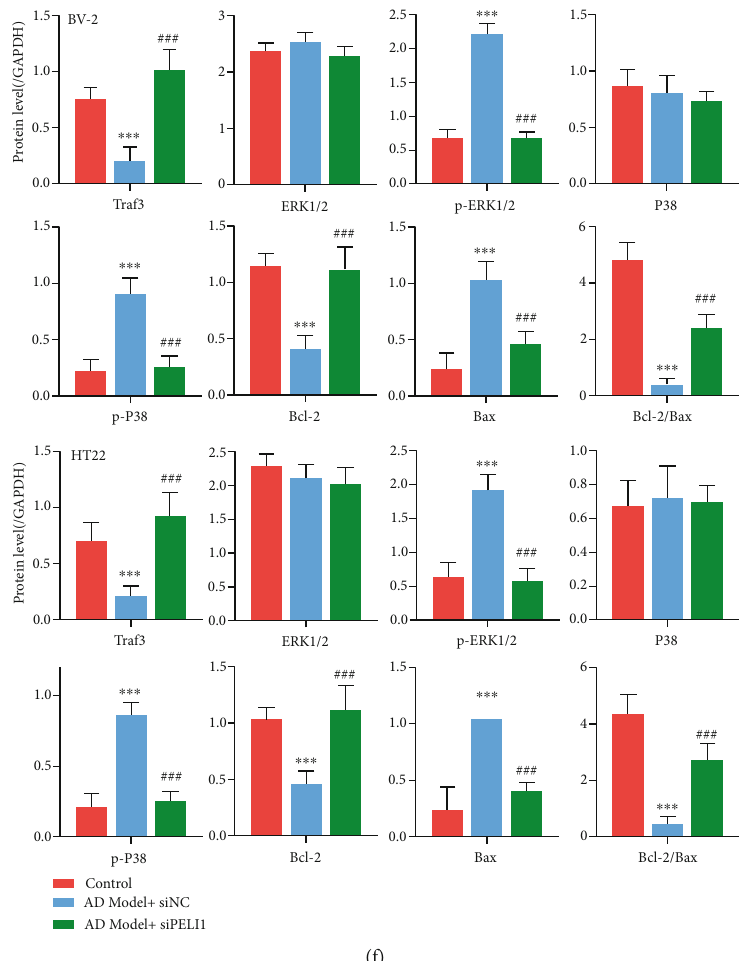
Figure 5: E ff ect of PELI1 silence on A β -induced BV-2 and HT22 cells. (a, b) The mRNA and protein levels of PELI1 in BV-2 or HT22 cells treated with A β (AD model), A β +siNC (negative control), and A β +siPELI1, respectively, by qPCR and western blotting. (c, d) Cell viability of BV-2 or HT22 cells treated with A β , A β +siNC, and A β +siPELI1, respectively, by CCK-8 assay. (e) The cell apoptosis of BV-2 or HT22 cells treated with A β , A β +siNC, and A β +siPELI1, respectively, by TUNEL assay (blue, nucleus; green, TUNEL-positive cells). (f) The expression of Traf3, phosphorylation levels of ERK1/2 and P38, and apoptosis-related proteins (Bcl-2 and Bax) in BV-2 or HT22 cells treated with A β , A β +siNC, and A β +siPELI1, respectively, by western blotting. Each experiment was repeated three times. ∗∗∗ P < 0 : 001 vs. control group; ### P < 0 : 001 vs. AD model